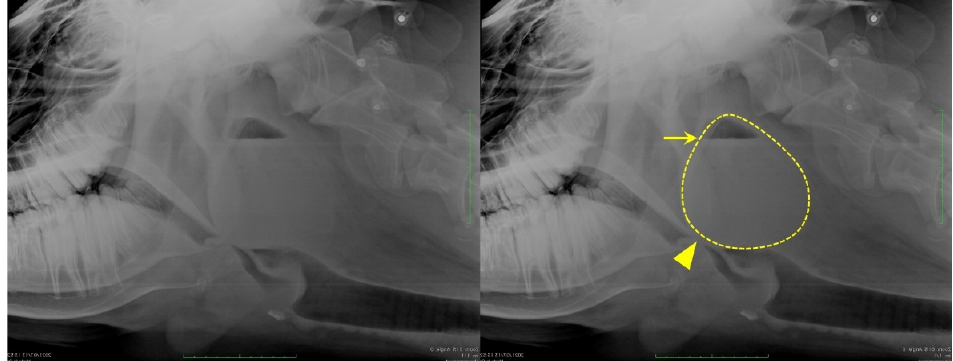
Figure 1. Lateral radiography of the pharyngeal area of the cow showing a retropharyngeal abscess obstructing the laryngeal airway (arrowhead). The dashed line indicates the mass outline, and the arrow points to the horizontal demarcating line, which indicates the presence of fluids.